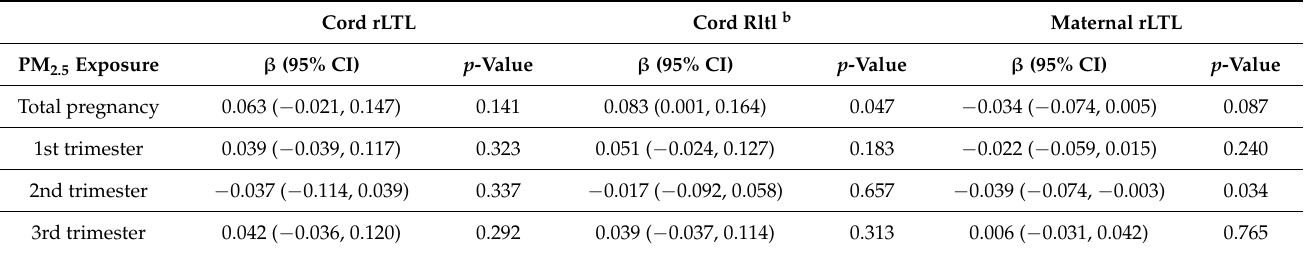
Table 2. Associations between binary (high versus low) PM 2.5 exposure a during pregnancy and rLTL in cord blood and maternal blood collected at delivery (n = 193).